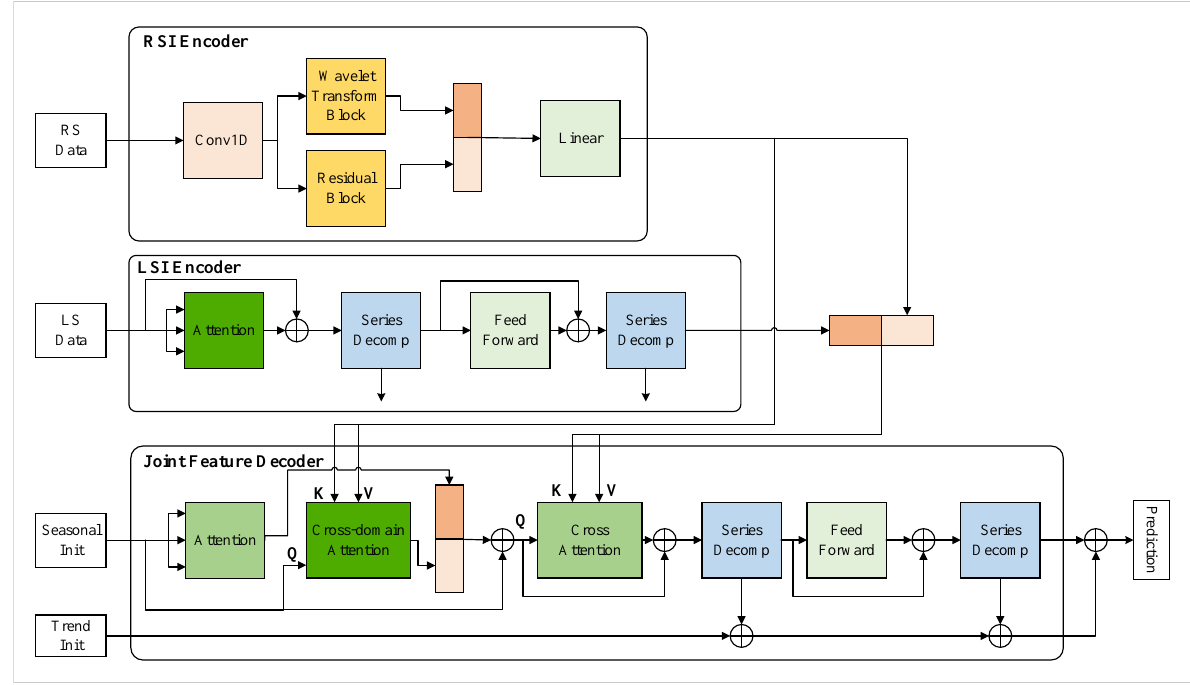
Figure 1. Model architecture of